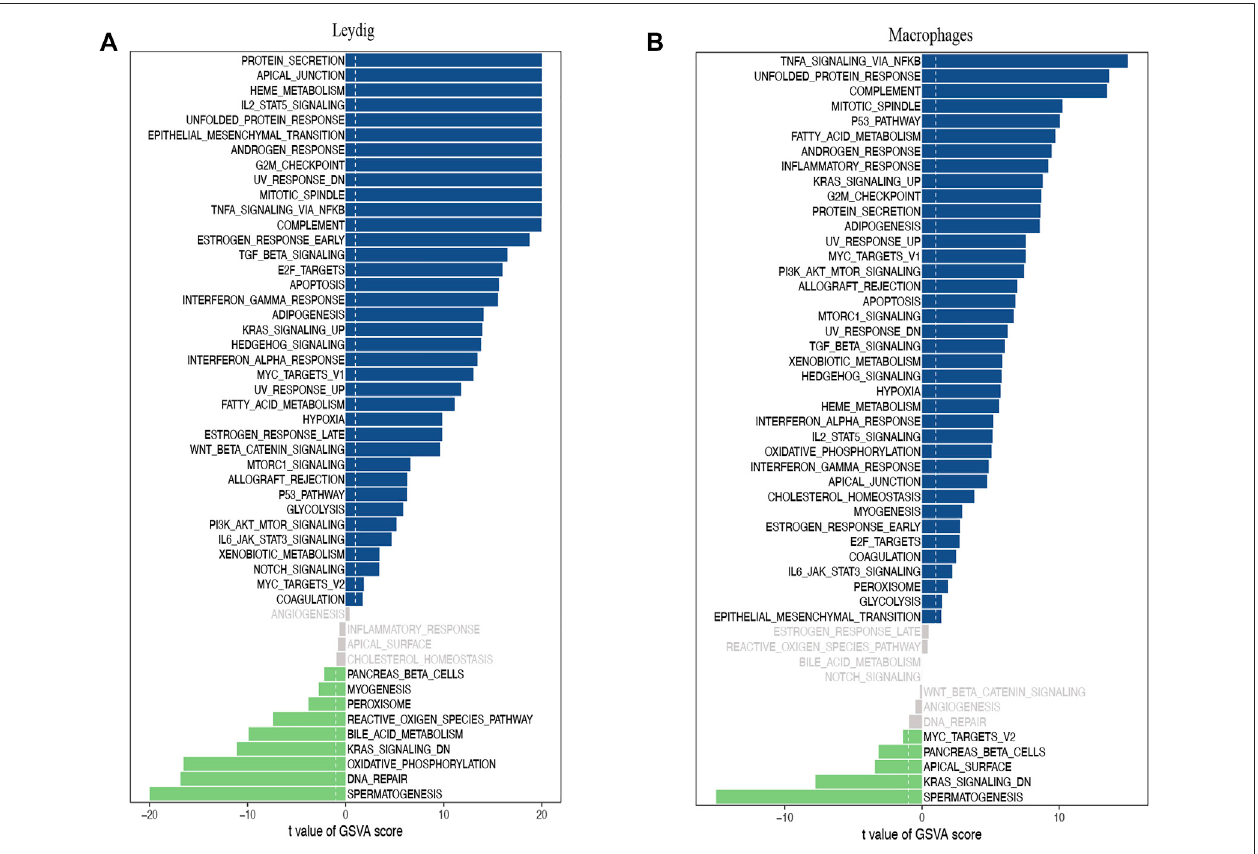
FIGURE 3 | Gene set variation analysis (GSVA) of testicular somatic cells in the normal group and the idiopathic non-obstructive azoospermia (iNOA) group. (A) Differences in pathway activities scored per cell by GSVA between normal and iNOA Leydig cells (n = 968 and 9,412 cells, respectively; six patients per group). (B) Differences in pathway activities scored per cell by GSVA between normal and iNOA macrophages (n = 144 and 763 cells, respectively; six patients per